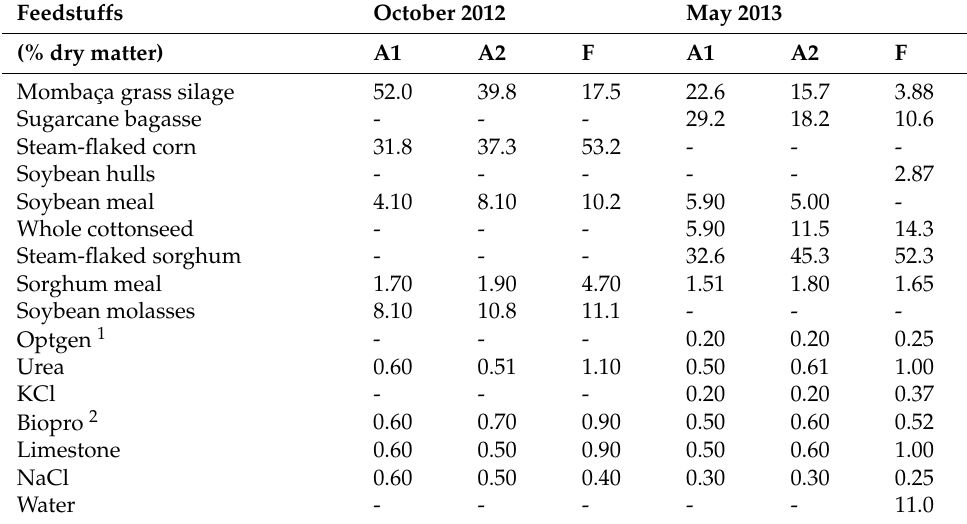
Table 1. Ingredients of the diets of finishing feedlot (traditional system). Feedstuffs